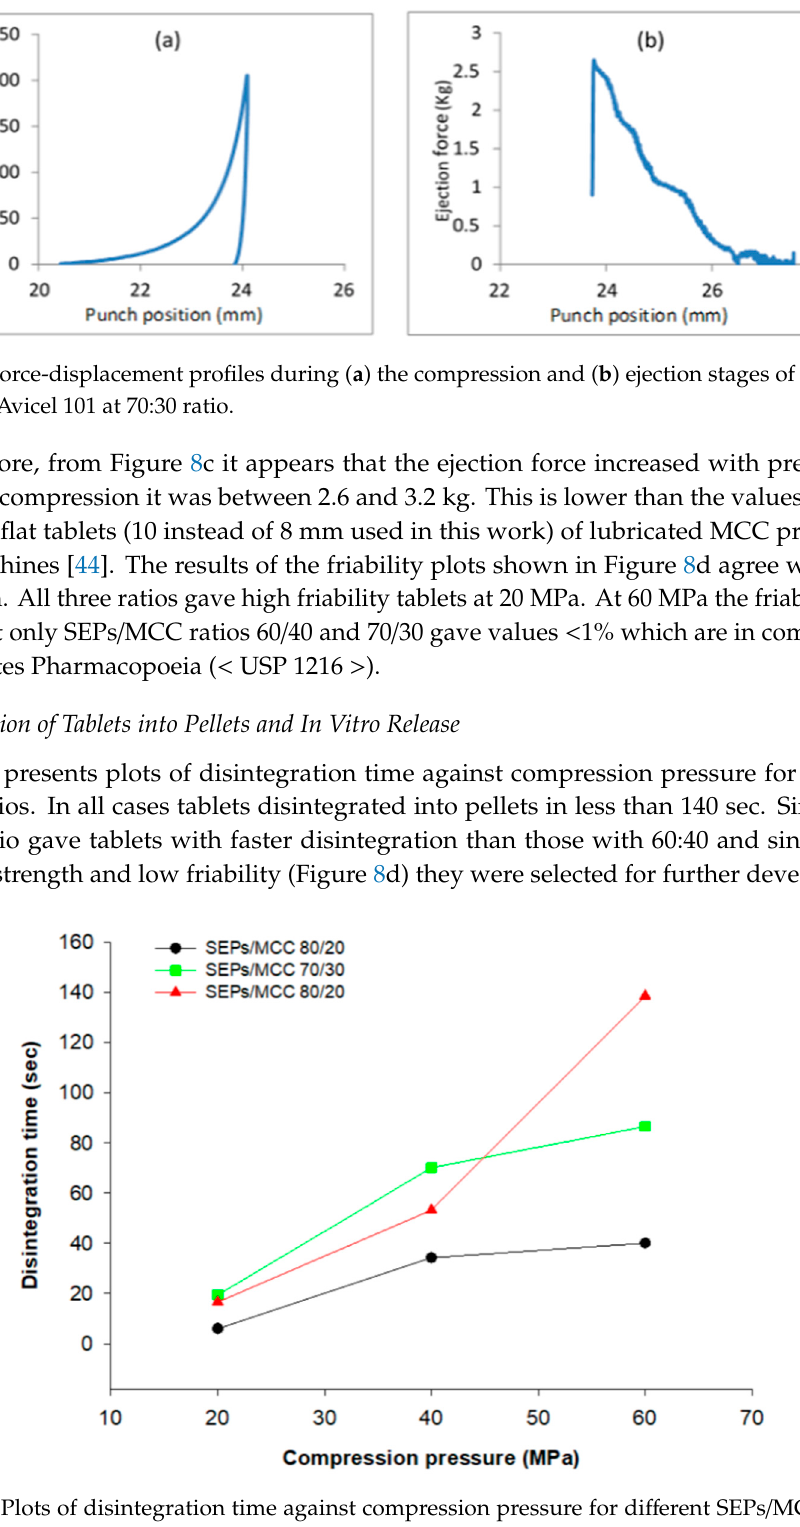
Figure 11. Drug release from unprocessed powder (circles), commercial tablets (square), self- emulsifying pellets (triangles), and self-emulsifying tablets (inverse triangles) at pH 1.2 (broken lines) and pH 6.8 (solid lines). Figure 11 presents drug release from unprocessed powder (circles), commercial tablets (square), self-emulsifying pellets (triangles), and self-emulsifying tablets (inverse triangle). The dissolution medium was phosphate buffer of pH 6.8 as recommended by the FDA (Drug Databases/Dissolution Methods 2004) due to the low solubility of AtrCa in acidic media. It can be seen that the release of AtrCA from commercial tablets is rapid reaching plateau after about 45 min, whereas the release from SEPs and SETs is slower reaching plateau after about 60 min. The slower release is ascribed to gel formation by the CSD present in the formulation, delaying passage of the drug from the SEDDS to the dissolution fluid. Assuming a residence time in the stomach and small intestine of about 4–6 h this delay of about 15 min should not affect significantly absorption since permeability of the self- emulsifying forms is greater (see later). However, since for immediate release tablets fast release is